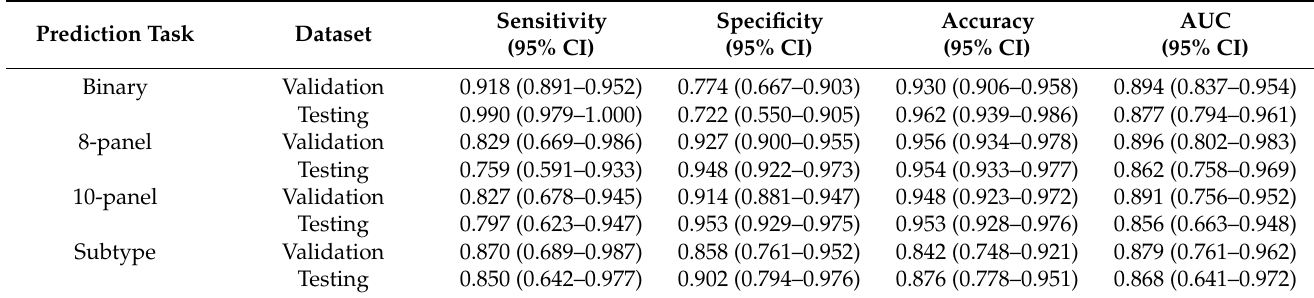
Table 3. Predictive performance of MMDL hybrid